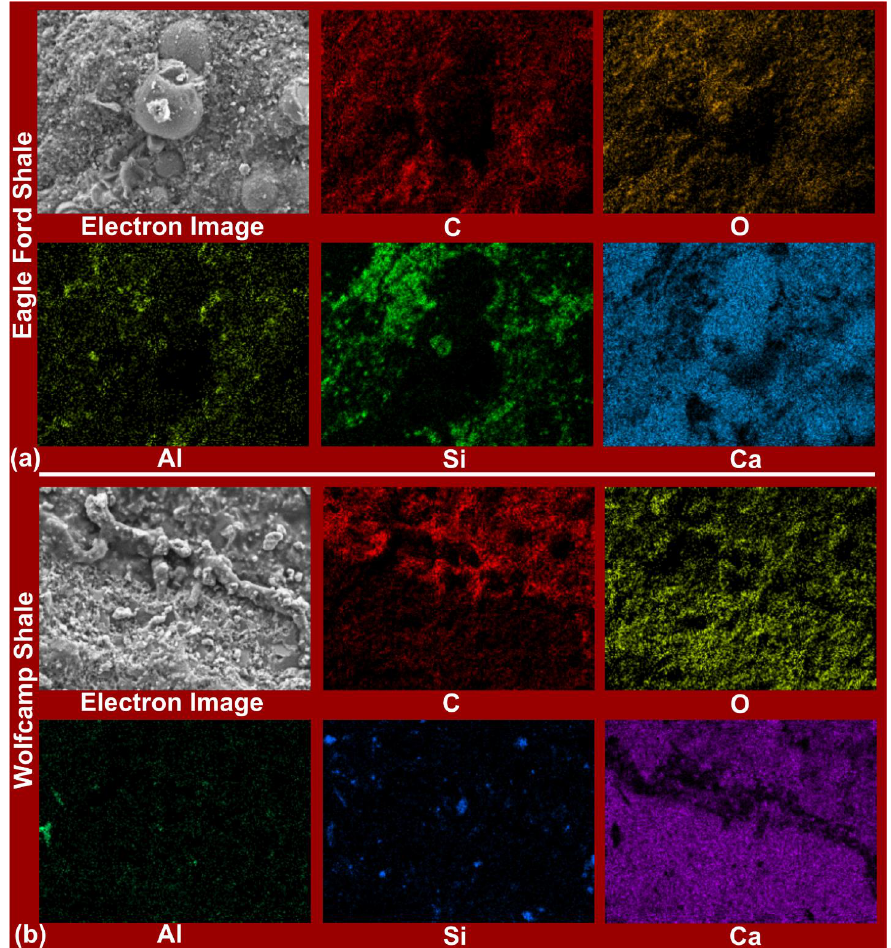
Figure 5. Elemental distribution maps of ( a ) Eagle Ford shale and ( b ) Wolfcamp shale. Detected elements were represented with their chemical symbols (C: carbon, O: oxygen, Al: aluminum, Si: silicon, and Ca: calcite).